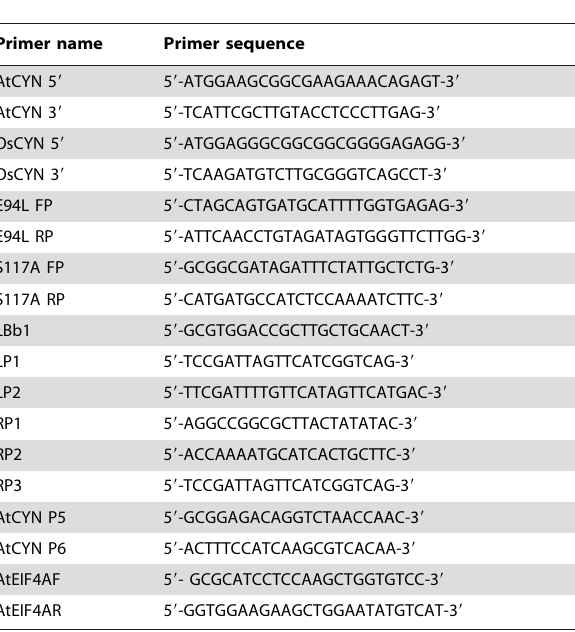
Table 3. List of primers used in this